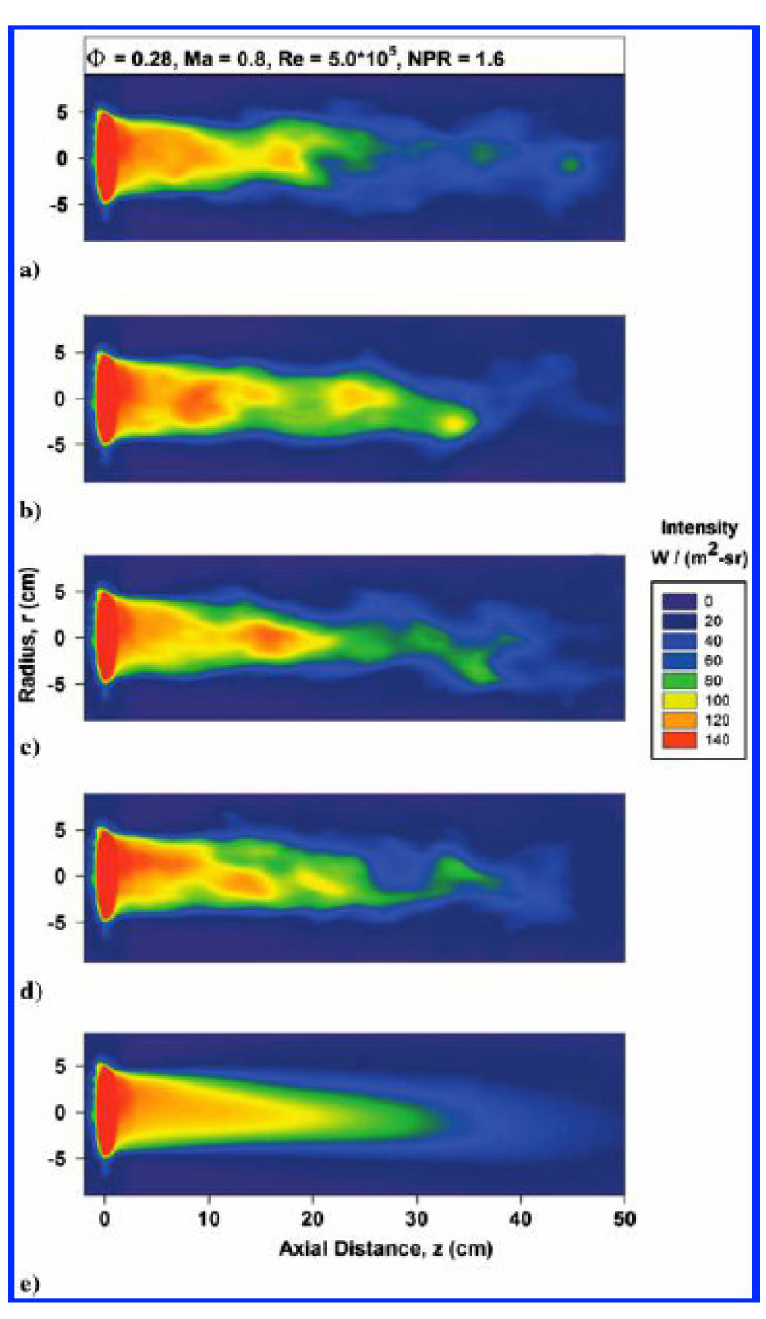
Figure 3. Infrared radiation intensity measurements in a plume (Mach 0.28, exit temperature 800 K): ( a – d ) instantaneous (elapsed time of 12 ms); ( e ) averaged. (from [14]). In the same context of infrared signature measurements, Packan et al. [16] have carried out an extensive experimental campaign on radiation in low temperature air plasma. For the tests, air was containing small quantities of CO 2 and H 2 O, measurements were performed in a 50 kW inductive plasma torch at 3400 K. Measured emitted spectrum is shown in Figure 5, highlighting the contributions of NO, OH, CO, and CO 2